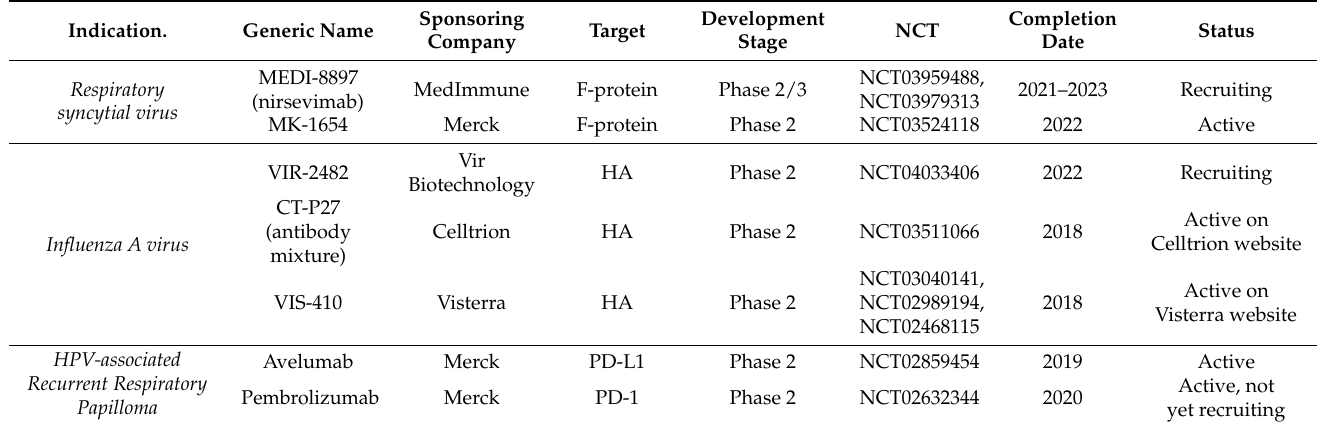
Table 2. Therapeutic antibodies for viral respiratory